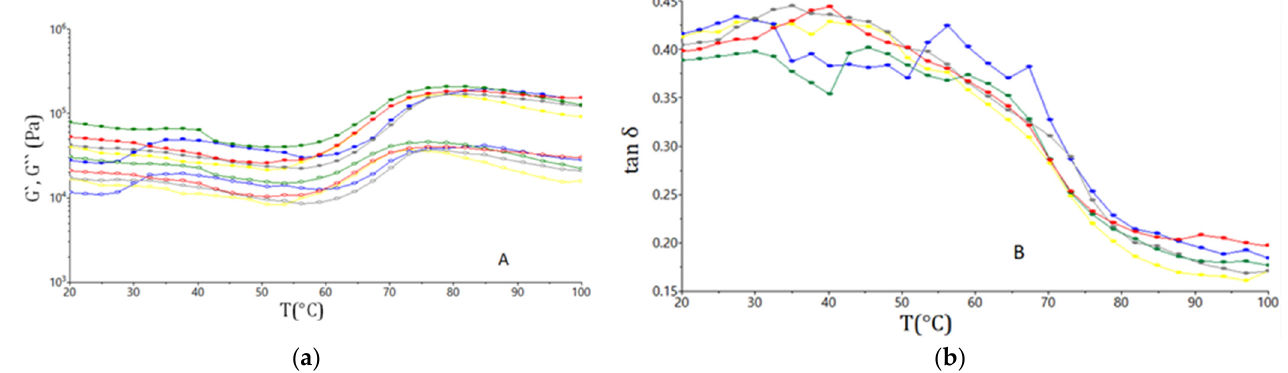
Figure 2. Evaluation with temperature of the G ′ values (open symbols), G ′′ (solid symbols) ( A ) and tan δ ( B ) for the samples with different levels (- ● -0%; - ● -5%; - ● -10%; - ● -15%; - ● -20%) of germinated chickpea flour additions.